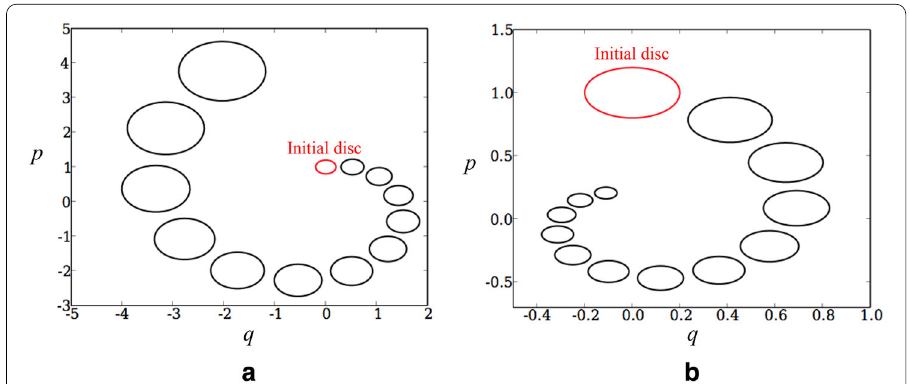
Fig. 1 Harmonic oscillator. Evolution of a disc (in red at t = 0) with the flow of explicit and implicit Euler schemes. a Explicit Euler scheme. b Implicit Euler scheme